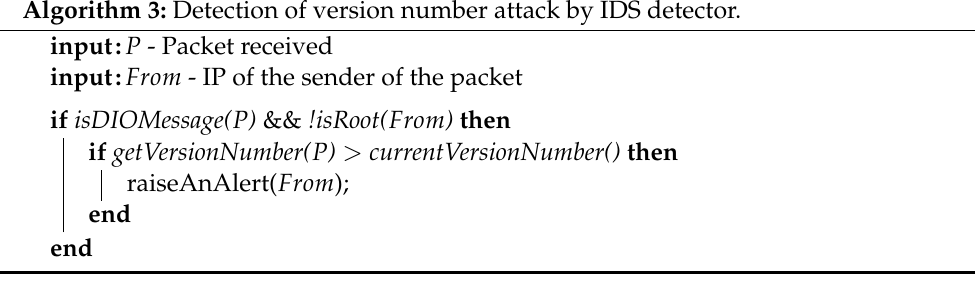
Algorithm 4: Threshold T i calculation by node i (i.e., IDS detector) to detect the rank decrease